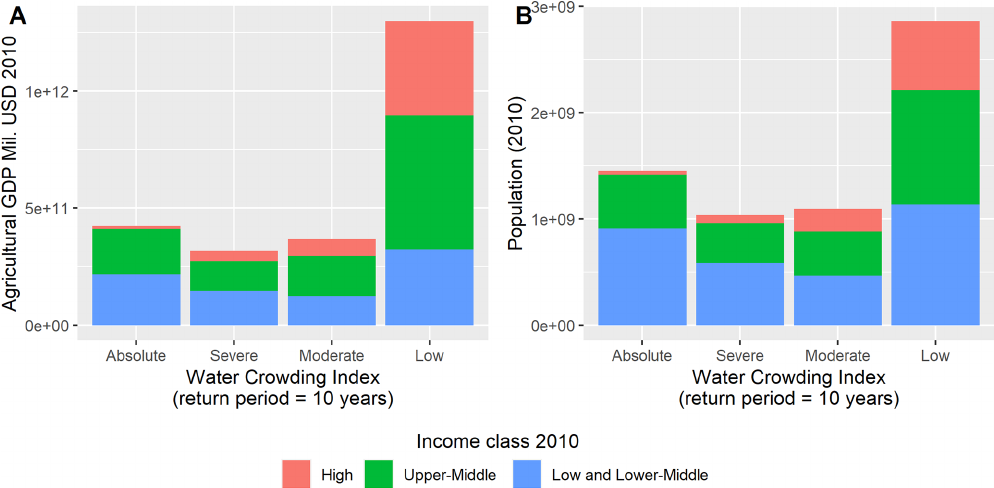
Figure 10. Total AgGDP (a) and population (b) by mean Water Crowding Index, where absolute is less than 500m 3 per capita per year, severe is less than or equal to 1000m 3 per capita per year, moderate is less than or equal to 1700m 3 per capita per year, and low is the remainder (Veldkamp et al., 2015; World Bank,